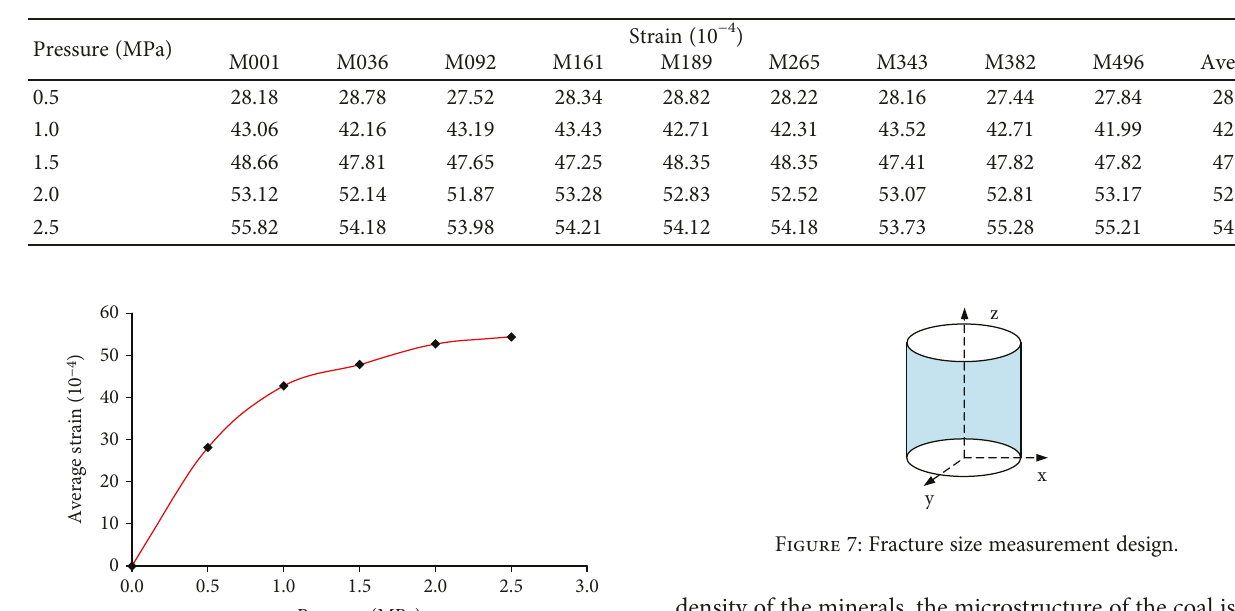
Figure 5: Schematic diagram of strain Table 1: The strain of coal layer under di ff erent pressures.